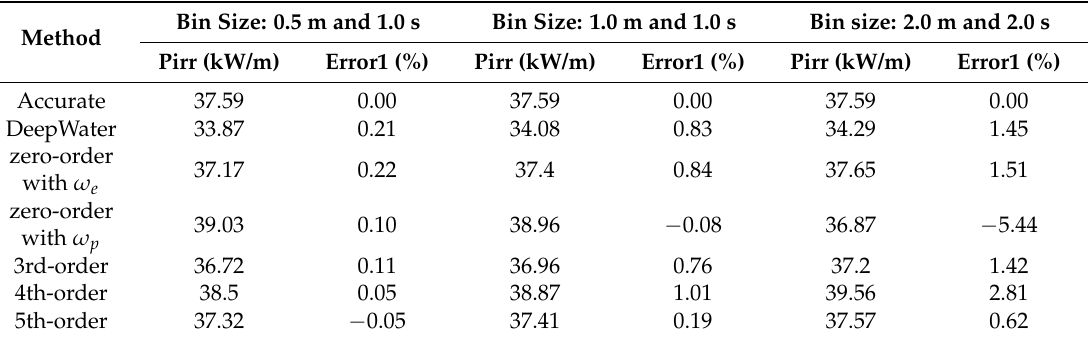
Table 4. Wave power assessment for AMETS (water depth: 50 m).